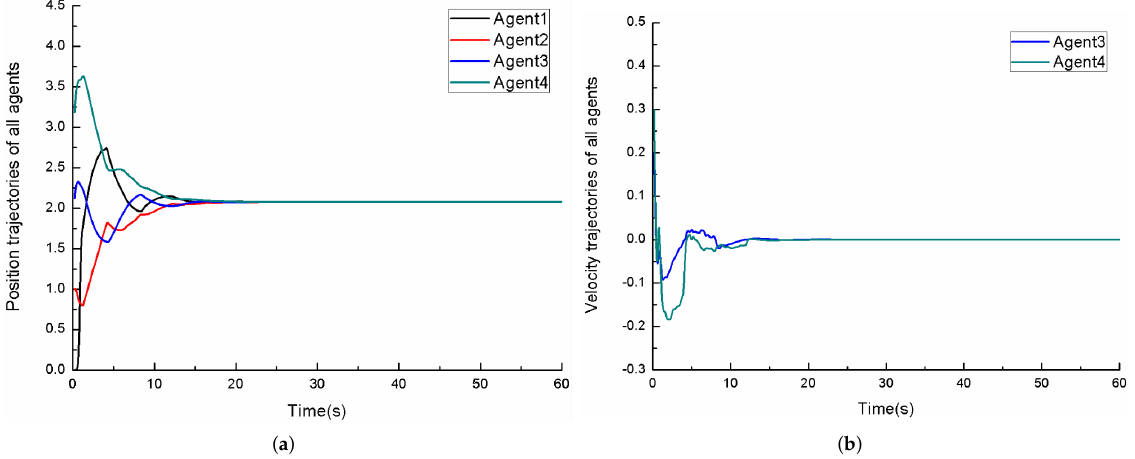
Figure 4. Position and velocity trajectories of heterogeneous time-delay MAS (1). ( a ) Position trajecto- ries. ( b ) Velocity trajectories.